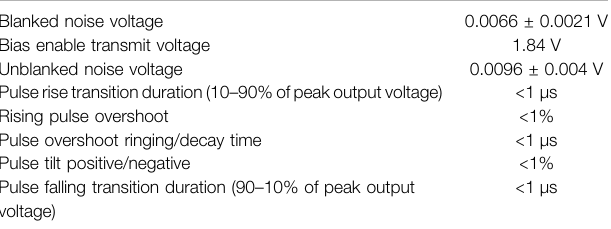
TABLE 3 | Measured pulse characteristics at 2.15 MHz at the output of the RF ampli fi er. Blanked noise voltage